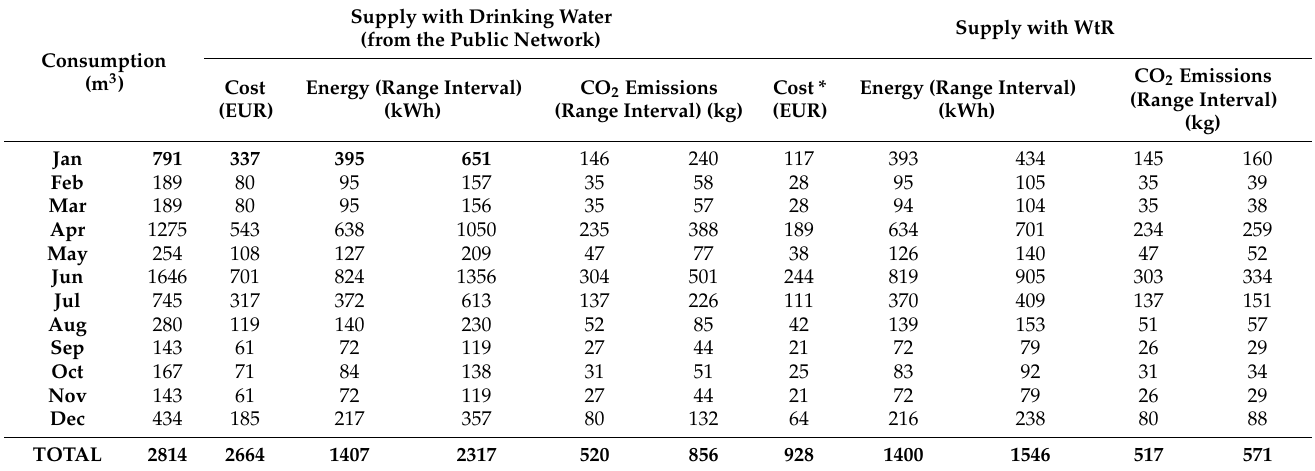
Table 4. Scenario 2: Supply with drinking water and WtR to municipal irrigation